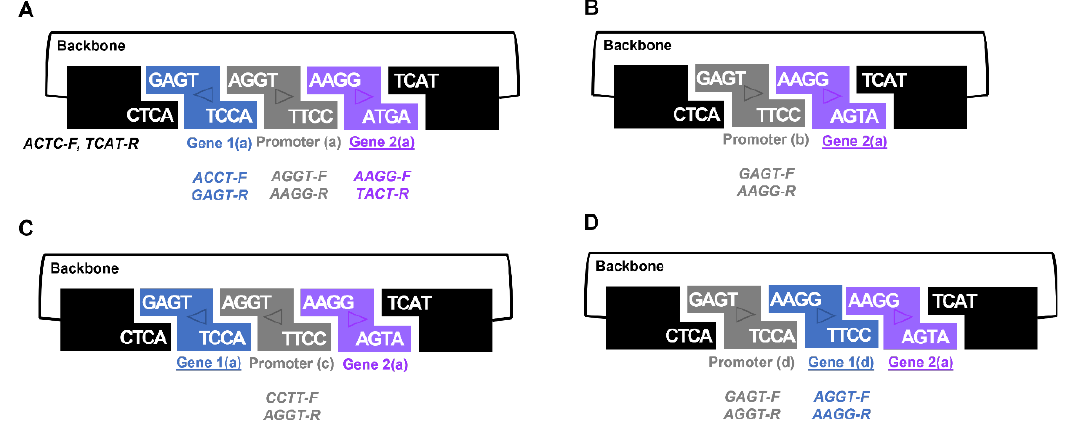
Figure 3. Flexible assembly of several genes in different combinations. Using the primers described here (in italics), it is possible to assemble different BioBricks in a variety of configurations, such as a promoter and two protein coding regions. In all cases here, the backbone is generated by amplification of pSB1C3 with the ACTC-F7 and TCAT-R7 backbone primers. ( A ) Amplification of genes 1 and 2, alongside a promoter, with the indicated primers generates compatible fragments for Golden Gate assembly. The resulting construct will lead to expression of gene 2 (indicated by underlined styling) but not gene 1, which is both upstream of the promoter and in reverse orientation. This